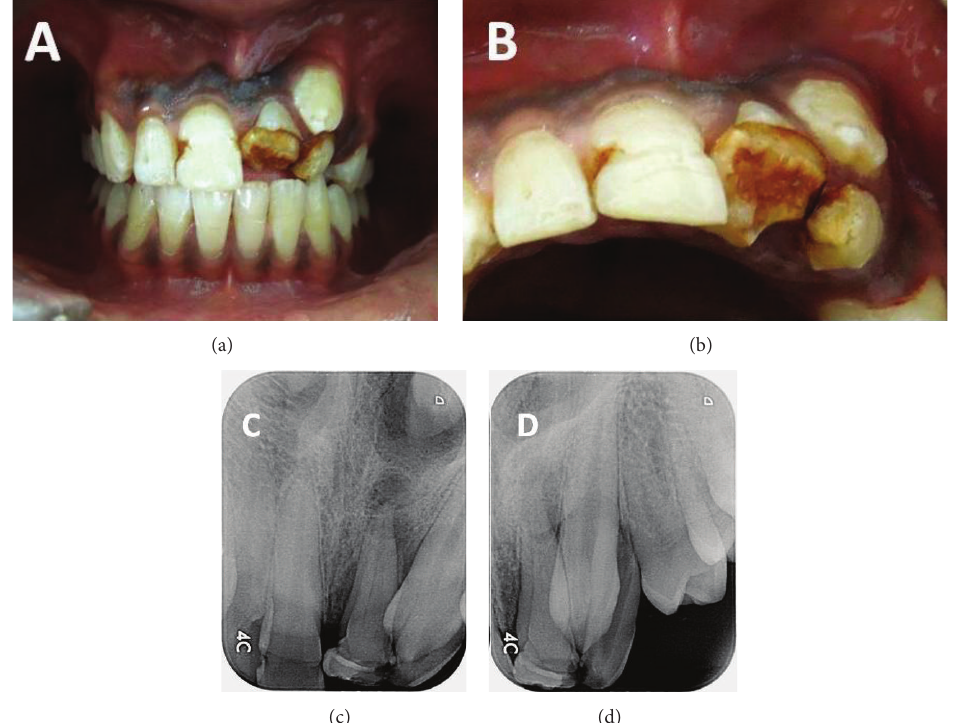
Figure 1: (a) Facial clinical view showing hypoplastic incisors, shortened lateral incisor crown, and mesioangularly placed canine. (b) Incisal clinical view of maxillary incisors showing acute palatal displacement of the crown in left central incisor and deficient enamel on the mesiolingual aspect of the left lateral incisor. (c) Preoperative intraoral periapical radiograph of left maxillary anterior region with anteroposterior projection. (d) Preoperative intraoral periapical radiograph of left maxillary anterior region with angulated